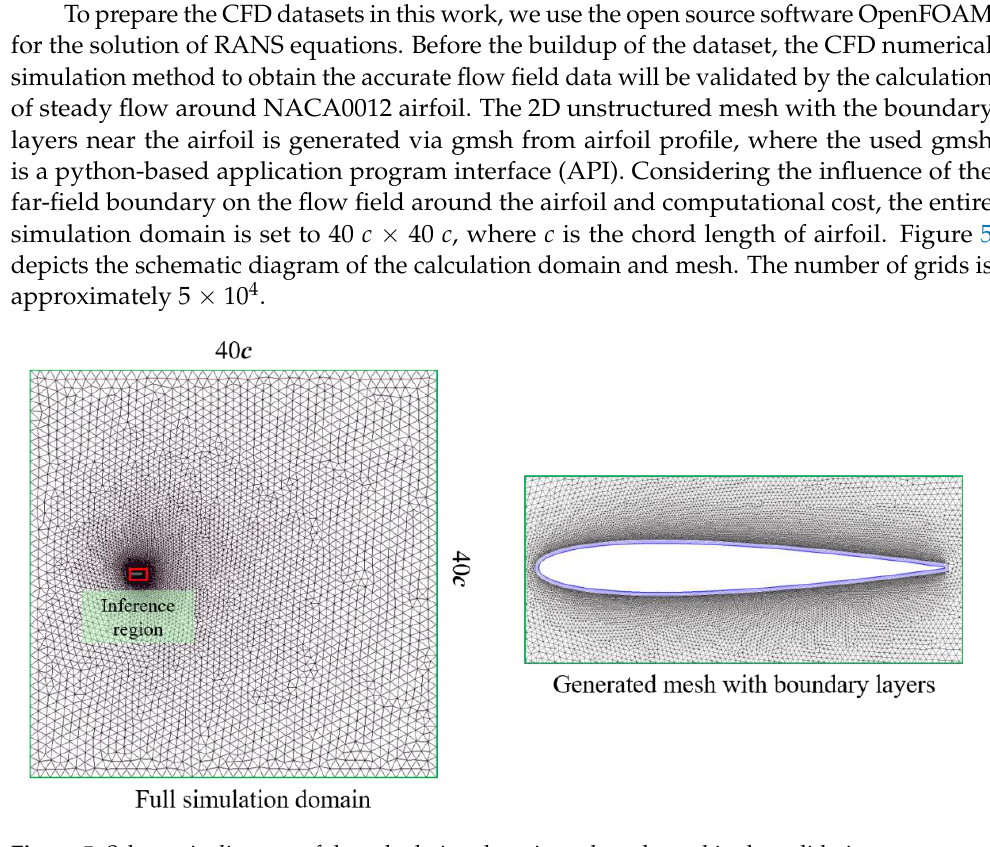
Figure 5. Schematic diagram of the calculation domain and mesh used in the validation